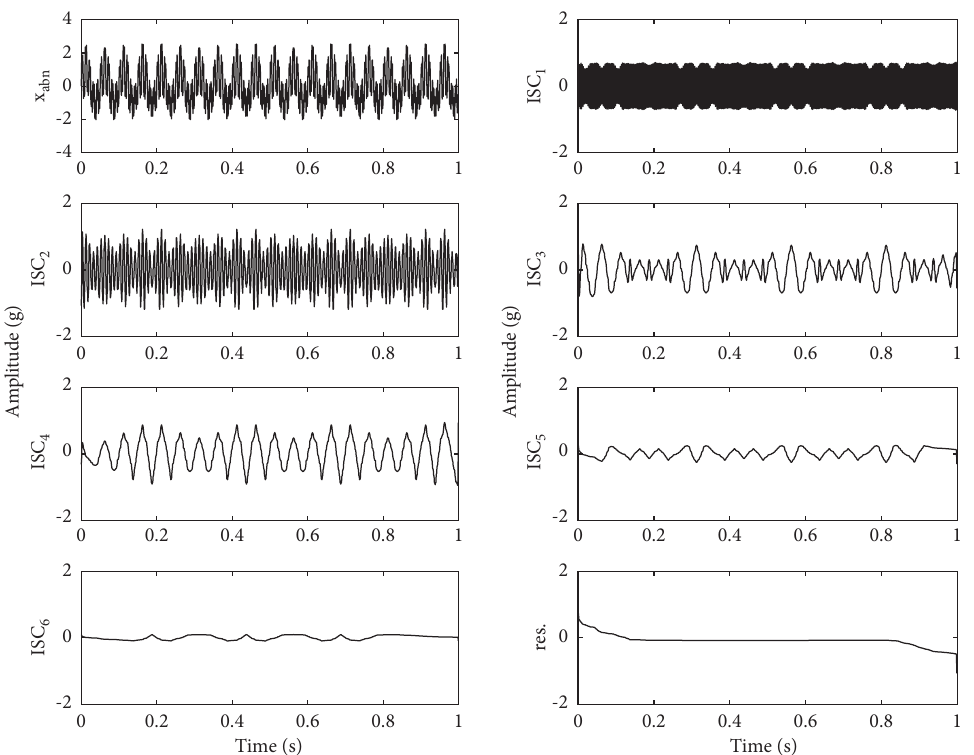
Figure 5: LCD decomposition results of x-channel under abnormal